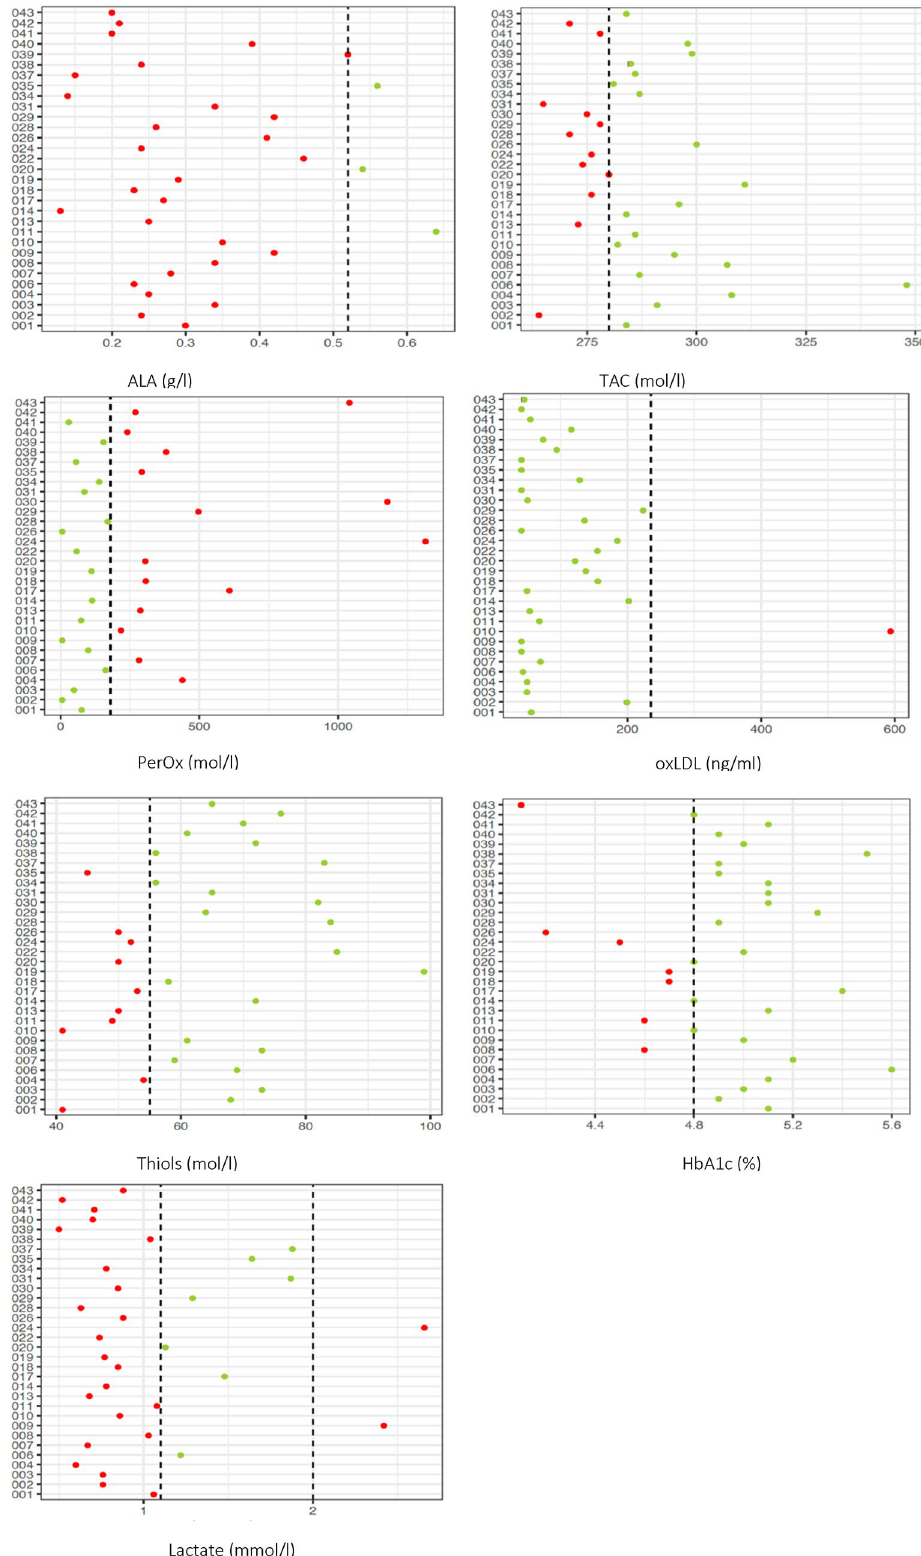
Figure 1. Baseline values of mitochondrial function markers for each patient. Dashed lines indicate the normal-range cut-off(s). Green dots indicate values within normal range, red dots indicate values outside the normal range. For alpha lipoic acid one very extreme value (13.25) has been removed for better visualisation. ALA = Alpha-lipoic acid; ox-LDL = oxidised LDL; PerOx = total lipid peroxide; TAC = total antioxidant